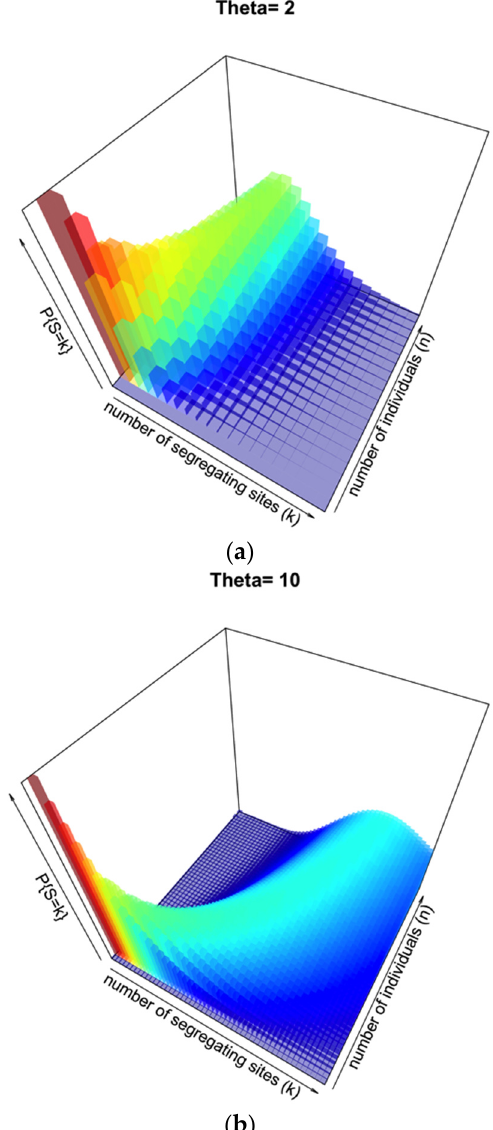
Figure 2. Probability surface of observing a number of segregating sites k for a given sample size n when θ is set. In ( a ), θ = 2; in ( b ), θ = 10.